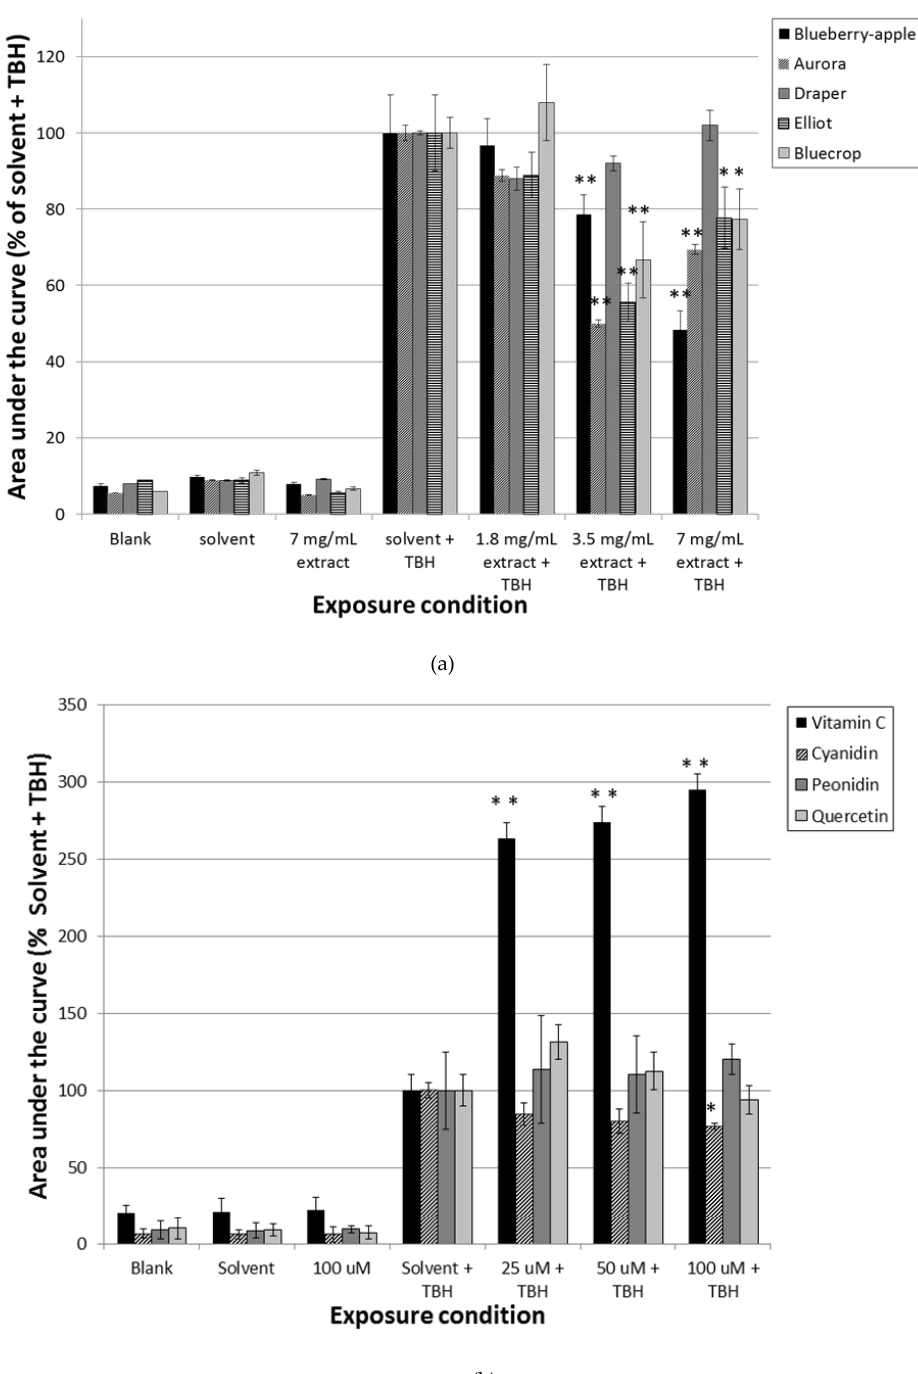
Figure 2. Radical formation in Caco-2 cells as measured by ESR spectroscopy. Results are expressed as percentage of solvent control levels. AUC: area under the curve of radical specific signals. Error bars indicate standard deviations. Caco-2 cells were pre-incubated for 2 h with different concentrations of the extract of blueberry – apple juice or extracts of four different blueberry varieties ( a ), or single compounds ( b ) and subsequently exposed to 150 µM tert-butylhydroperoxide (TBH) for 30 min. Pre-incubation for 2 h with medium, solvent control (0.5% end concentration of 70% methanol/0.1% formic acid), the maximal concentration of the different extracts (i.e., 7 mg/mL), or 100 µM of single compounds did not induce significant levels of radical formation. ** P < 0.01; * P < 0.05, significantly different from Caco-2 cells exposed to solvent control for 2 h and challenged with 150 µM TBH for 30 min.